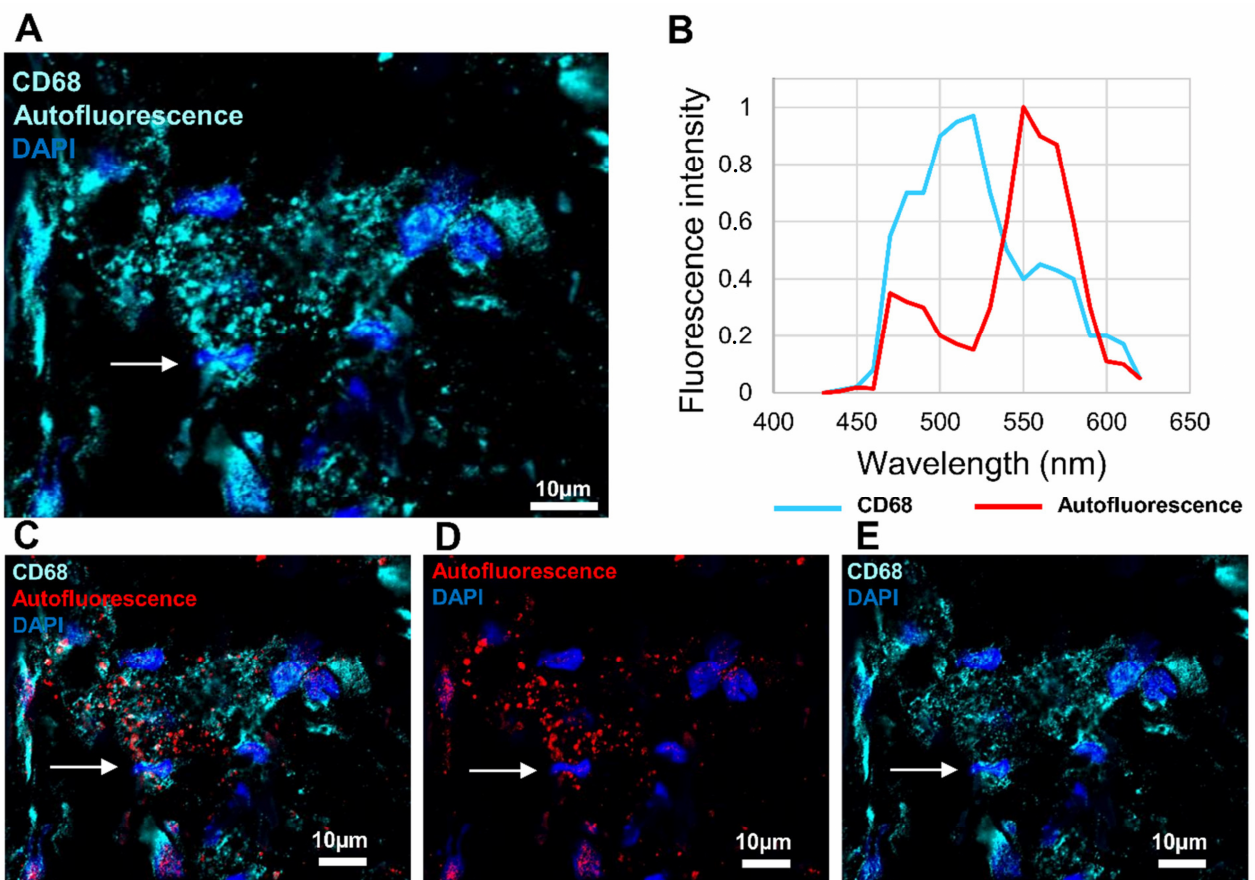
Figure 7. Identification of the in situ autofluorescence by microspectroscopy analysis. In the oper- ated femur, macrophages were labeled with anti-CD68 antibody. Tissues were excited at 488 nm. ( A ) Emission of the autofluorescence and the antigen-specific fluorescence (Alexa Fluor 488) with turquoise fluorescence. ( B ) Microspectroscopycal analysis of Alexa Fluor 488 emission (turquoise line) and autofluorescence (red line). ( C ) Separation of autofluorescence emission (red fluorescence) and antigen-specific fluorescence (Alexa Fluor 488) (turquoise fluorescence). ( D ) Emission of the aut- ofluorescence (red fluorescence). ( E ) Emission of the antigen-specific fluorescence (Alexa Fluor 488) (turquoise fluorescence). Nuclear staining with DAPI (blue fluorescence). Fine arrow: